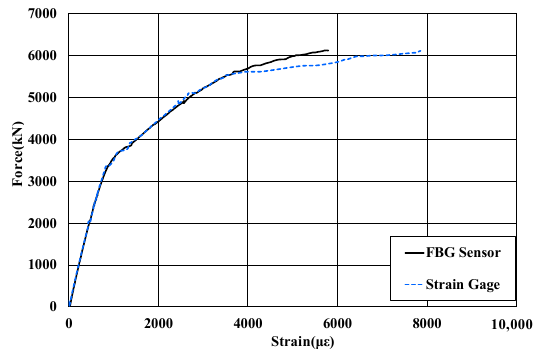
Figure 17. Comparison of strain measured by FBG sensor and strain gage in tendon one of BH girder bridge during the four-point bending test.